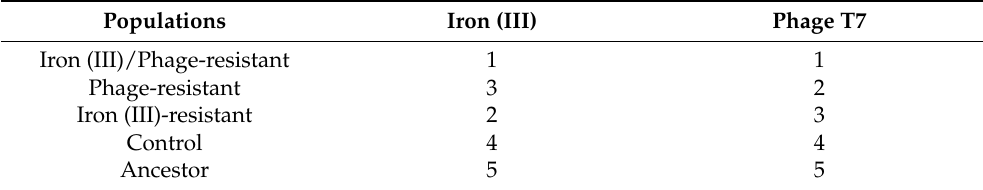
Table 2. Ranking of populations based on fitness in excess iron (III) and bacteriophage T7. The ranking of each population is shown relative to excess iron (III) and bacteriophage T7. The fact that the phage-selected population performed better than the controls or ancestors indicates that selection for bacteriophage resistance has pleiotropic effects on excess iron resistance. Similarly, the fact that the iron (III)-resistant population performed better against bacteriophage than the controls or the ancestor shows that excess iron (III) resistance has pleiotropic effects on bacteriophage resistance. Populations Phage